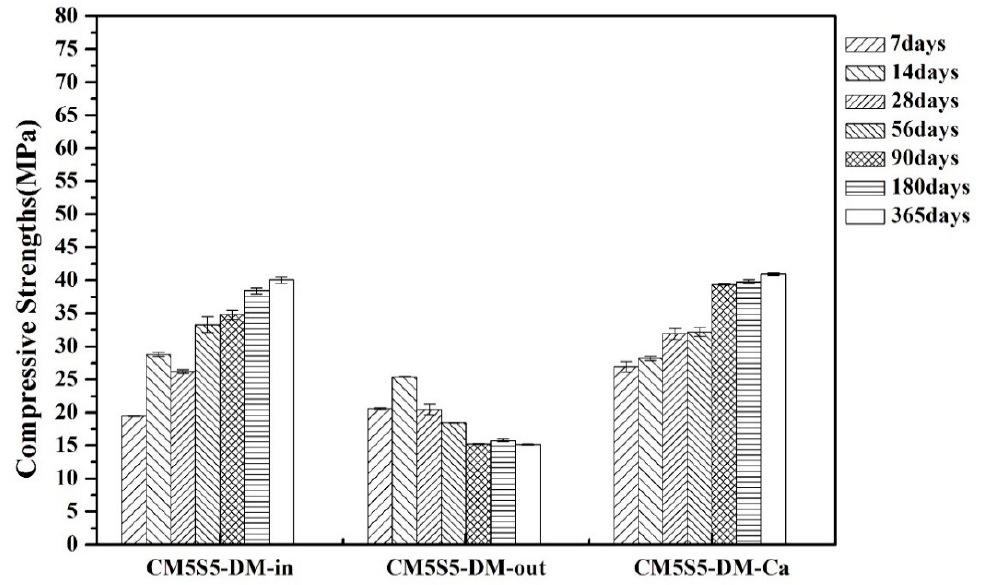
Figure 5. Effect of the curing environment on the compressive strength of marble-based geopolymer concrete (densified mixture designed ratio).